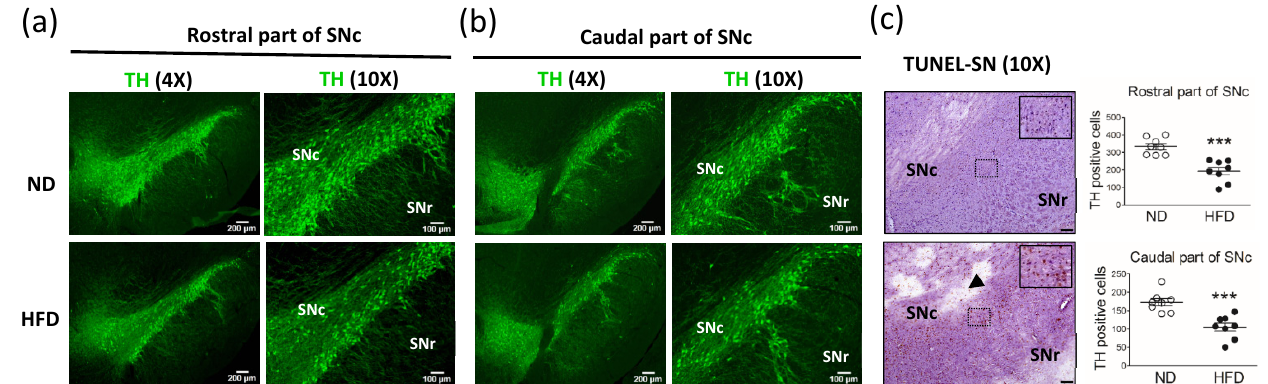
Figure 4. Immunostaining of dopaminergic neurons (tyrosine hydroxylase [TH]-positive cells) in the substantia nigra pars compacta (SNc) after middle-aged rats were fed a normal diet (ND, control, n = 8) or 45% high-fat diet (HFD, n = 8) for 30 weeks. Data were captured by using 4X (scale bar = 200 μ m) and 10X (scale bar = 100 μ m) objectives. Immunostaining for TH in neurons in the ( a ) rostral part of the SNc and ( b ) caudal part of the SNc. TUNEL staining (brown) for cell apoptosis and hematoxylin staining (blue) for cell nuclei in the ( c ) SNc and SNr. The arrow indicates the loss of nuclei. The quantifi- cation of TH-positive cells in the rostral and caudal parts of the SNc (4X objective) is shown. The TH-positive cells were quantified by using cellSens Dimension software (Olympus). Data are expressed as the mean ± SEM. *** p < 0.001 between groups ( t -test).